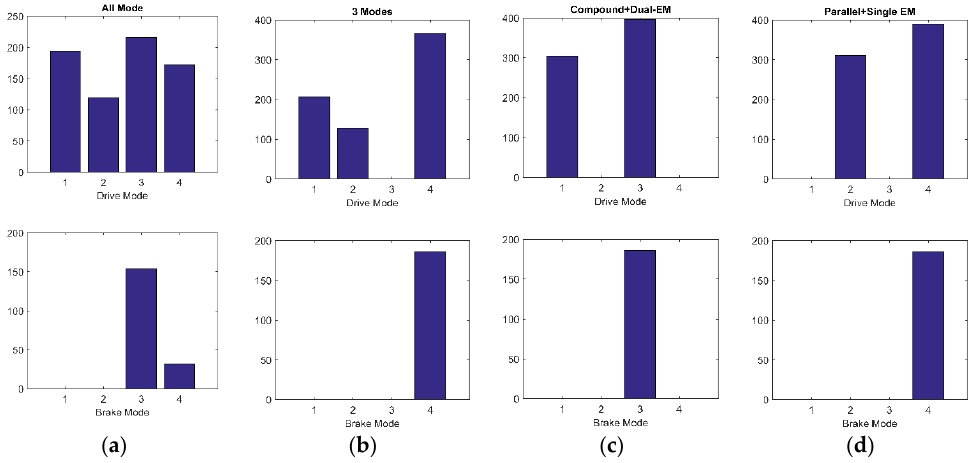
Figure 18. Frequency of mode utilization in four different configurations over the NEDC driving cycle: ( a ) All Mode Configuration; ( b ) 3 Modes Configuration; ( c ) Compound+Dual EM Configuration; ( d ) Parallel + Single EM Configuration.